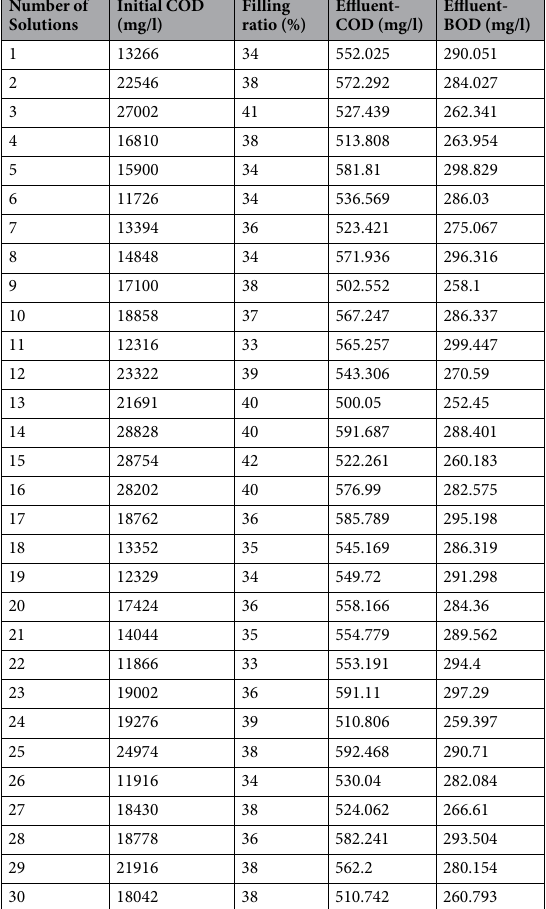
Table 7. Solution runs for MLL effluent discharge to municipal wastewater.